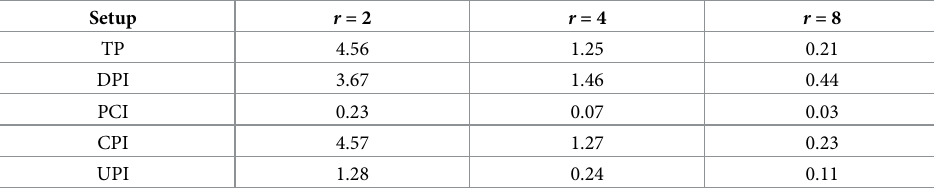
Table 1. ℓ 2 norm for the deviation of the velocity at the interface with respect to its FOM value for t 2 [0,